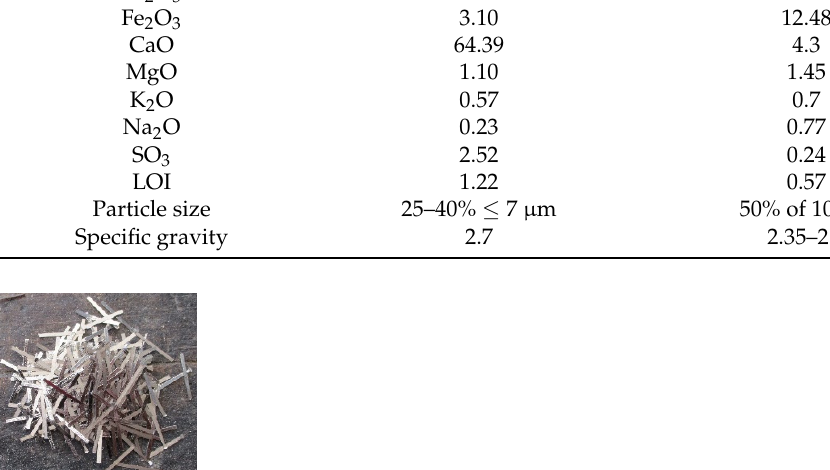
Figure 1. Amorphous Metallic Fibres used in this study ([18]). [Reproduced with permission from Table 1. Chemical composition and physical properties of OPC and Class F fl y ash in wt. % [18].